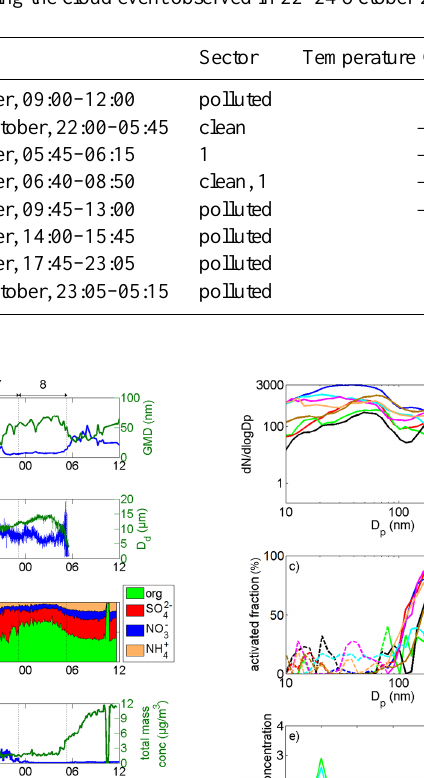
Table 5. Summary of the different periods during the cloud event observed in 22–24 October 2011.